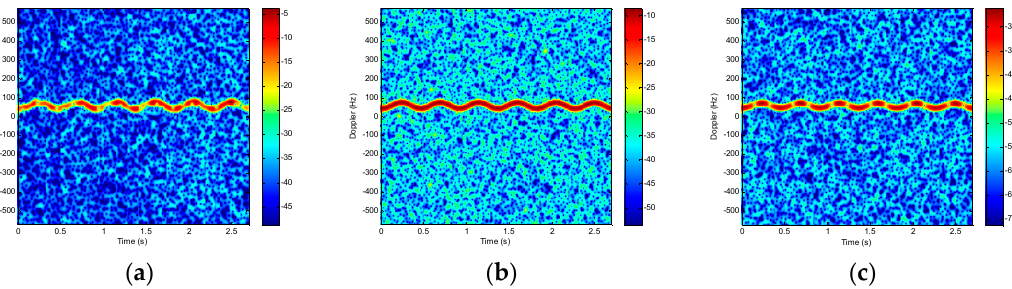
Figure 13. Decomposition results of IMF3 signals: ( a ) TFD of AMD1; ( b ) TFD of AMD2; ( c ) TFD of AMD3.